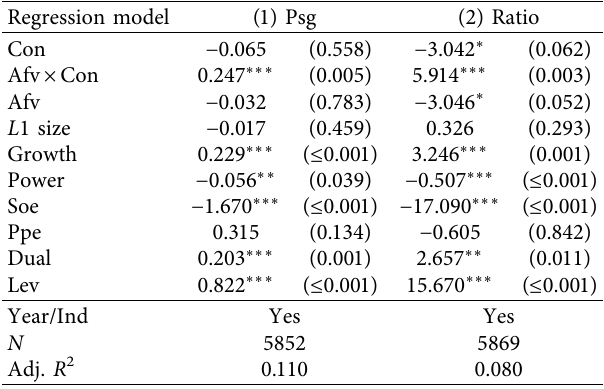
Table 4: Multiple regression of fair value measurement, over- confidence of major shareholders, equity pledge, and pledge ratio. Regression model